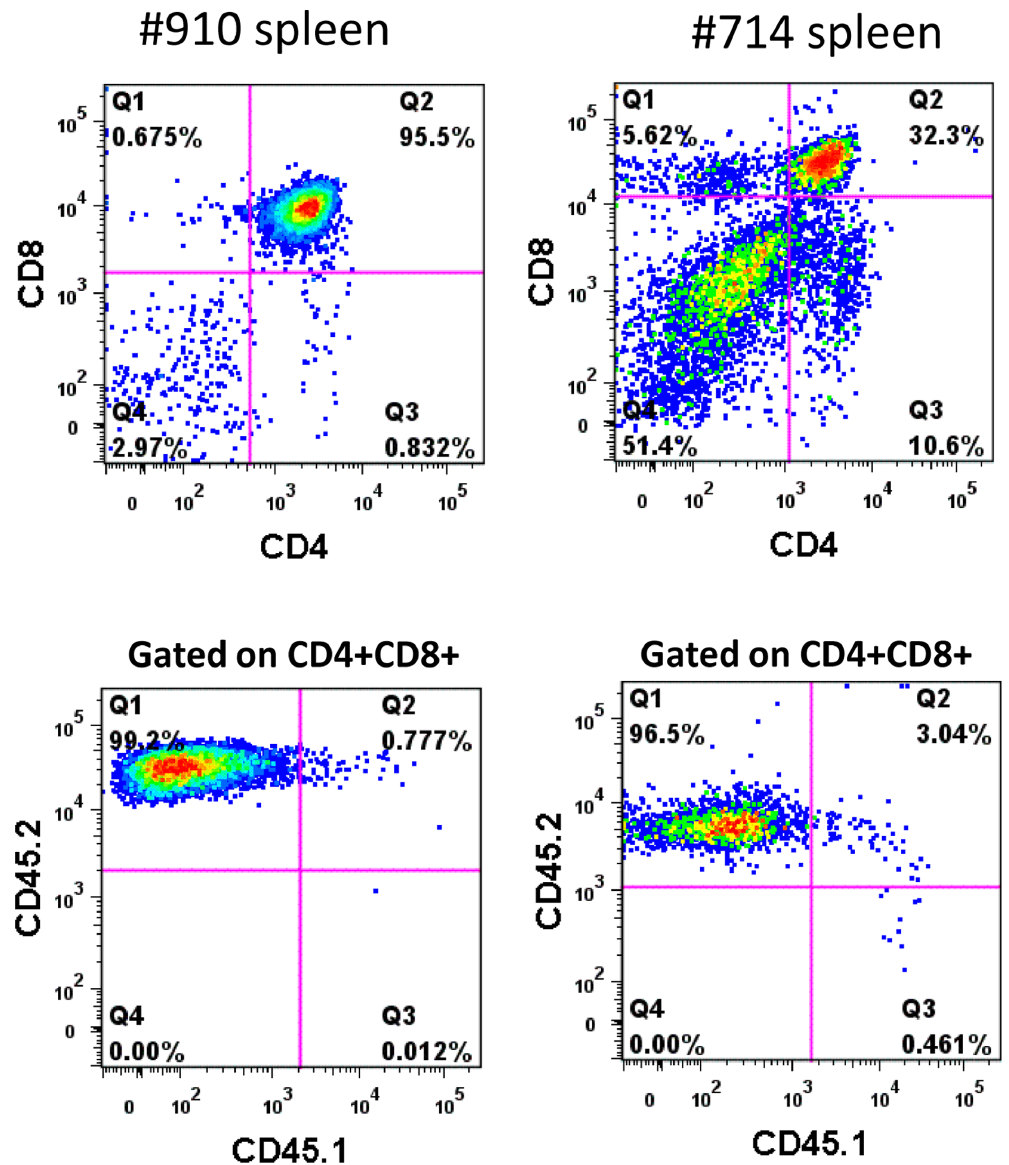
Figure 3. Recipient origin of T-cell malignancies arising in the secondary recipients of the EF1a group in experiment 2. Tumor cells derived from the spleen of transplanted mice were analyzed for CD4 and CD8 expression first (top panels). The abnormal CD4 + CD8 + leukemic cells were then gated and analyzed for CD45.1 (donor) and CD45.2 (recipient) marker expression. Virtually all CD4 + CD8 + cells exclusively expressed CD45.2 and were therefore derived from the irradiated recipient